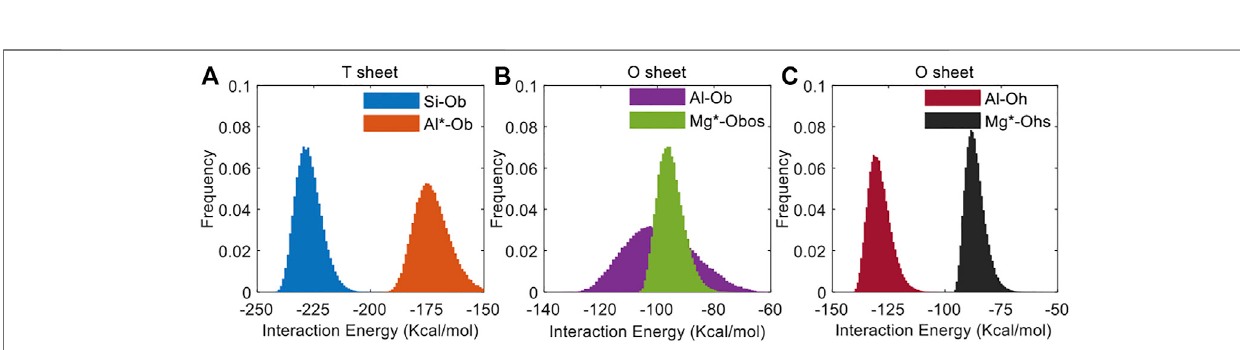
Frontiers in Earth Science |